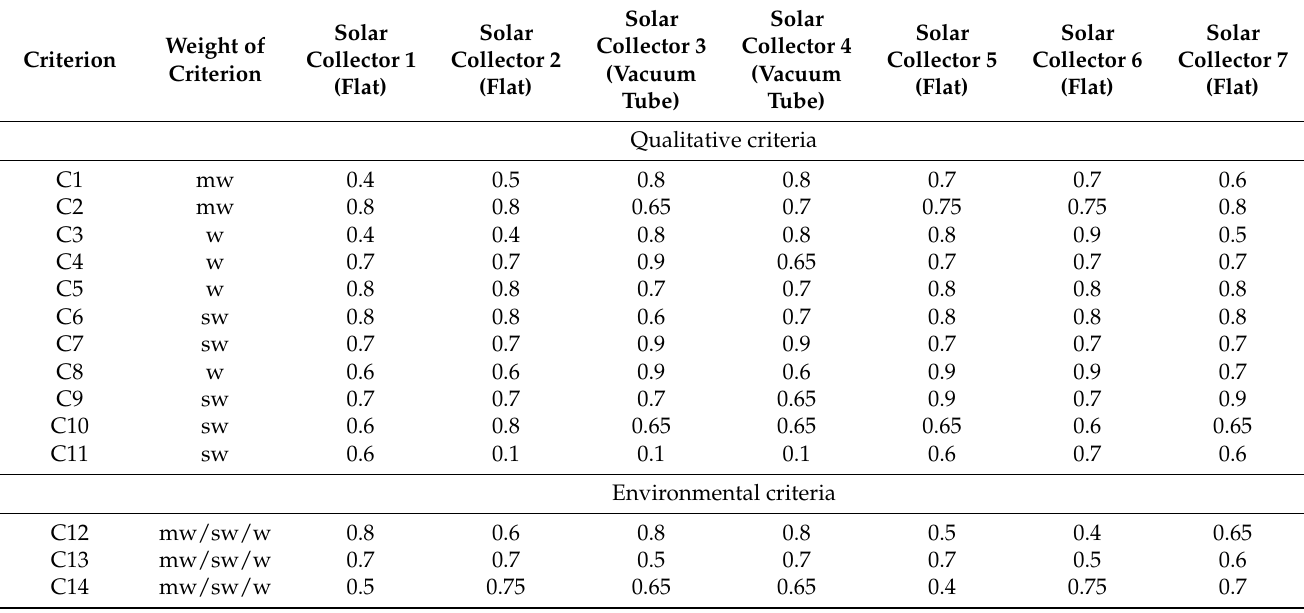
Table 3. Assessments of solar collector